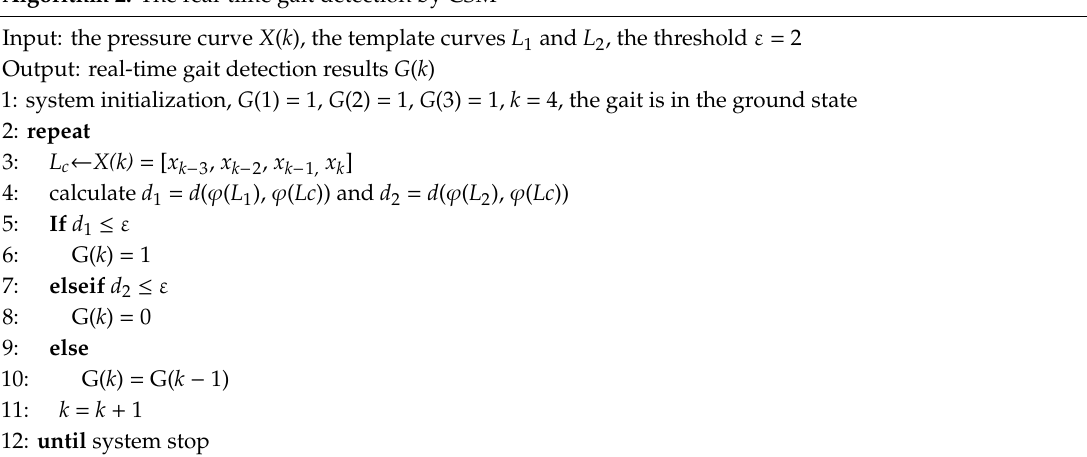
Algorithm 2. The real-time gait detection by